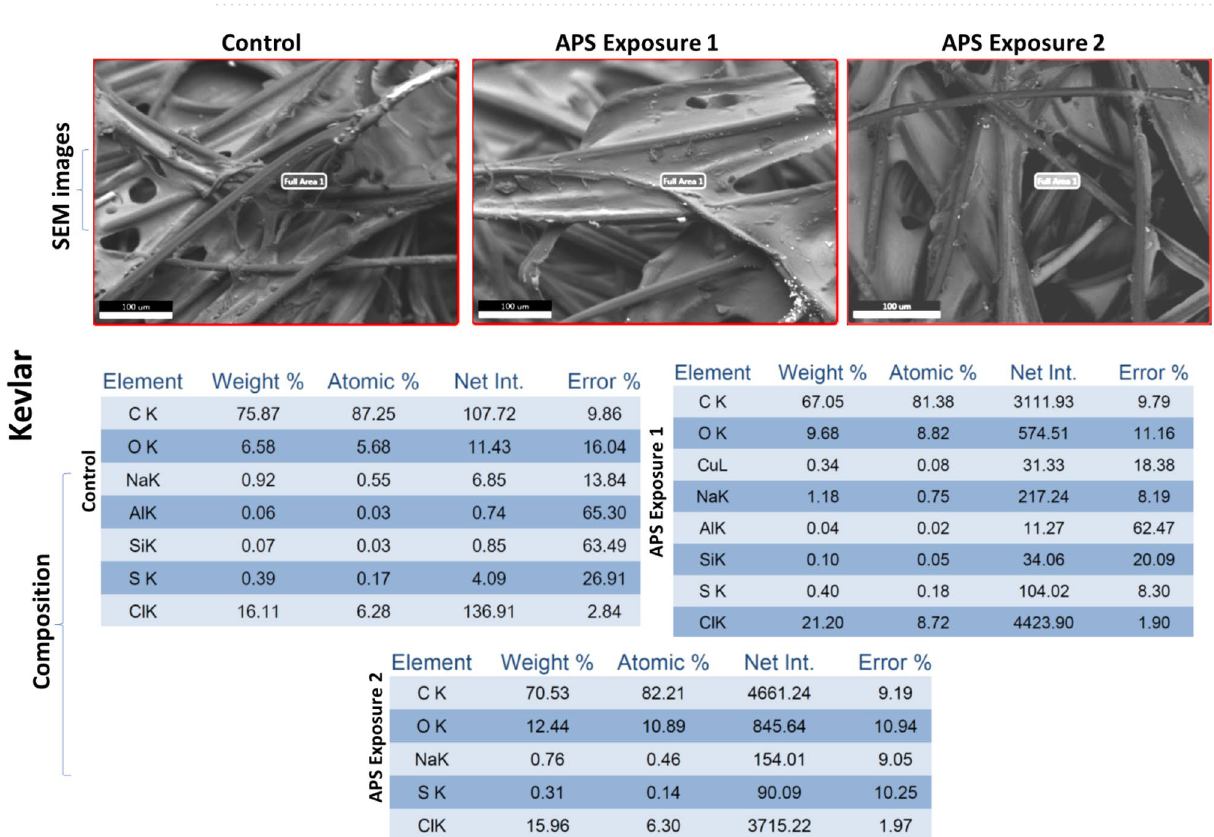
Figure 18. Material compatibility data: SEM analysis of Kevlar with APS exposure 1: exposed to ozone CT value of 6789.02 ppm-min, and APS exposure 2: exposed to ozone CT value of 10,323